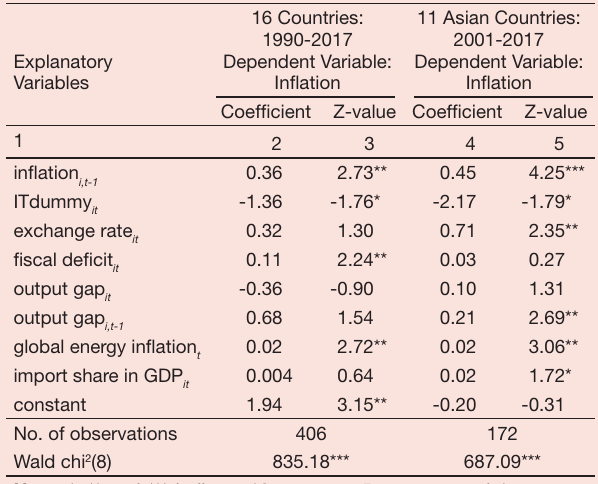
Table 1: Results of the Dynamic Panel Data models 11